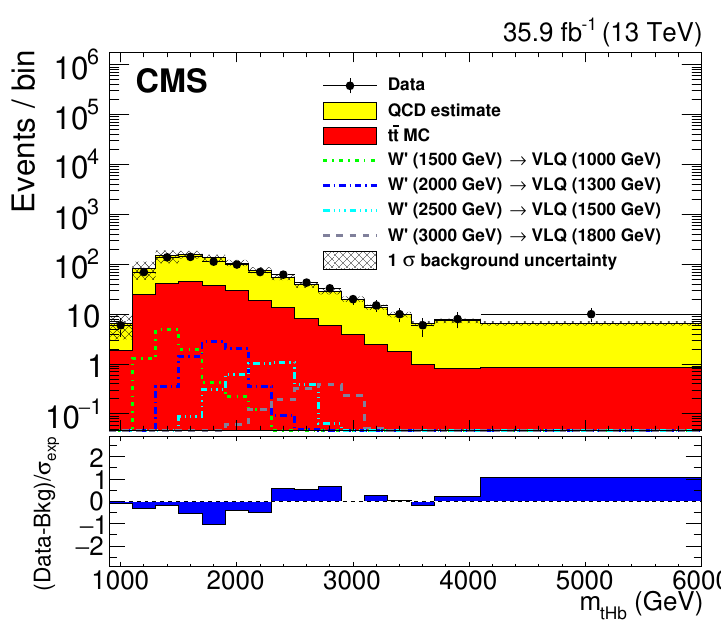
Figure 5 . Reconstructed W mass distributions ( m tHb ) in the b candidate inverted validation 0 region (VR) shown for data and background contributions. Several signal hypotheses are shown to demonstrate the low signal contamination. The background uncertainty includes all systematic and statistical uncertainties.